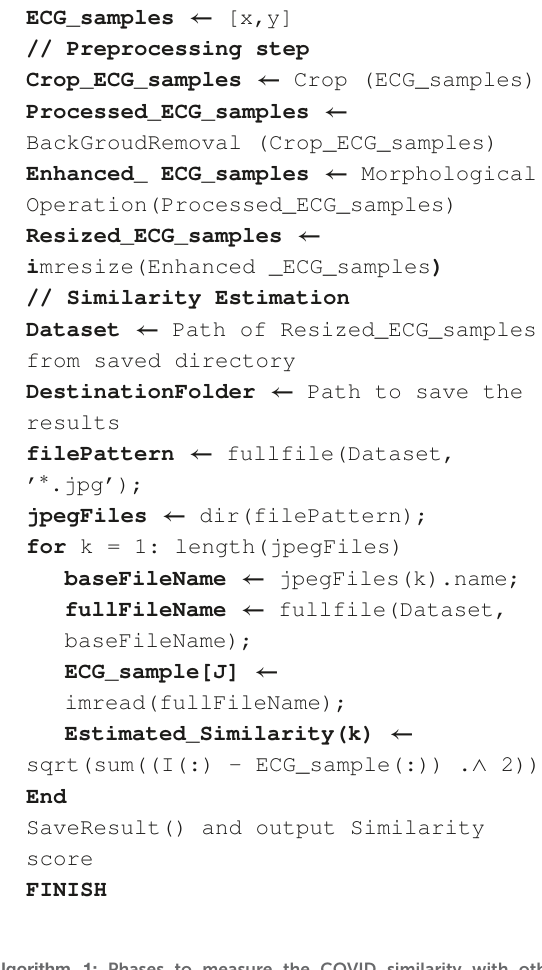
Algorithm 1: Phases to measure the COVID similarity with other